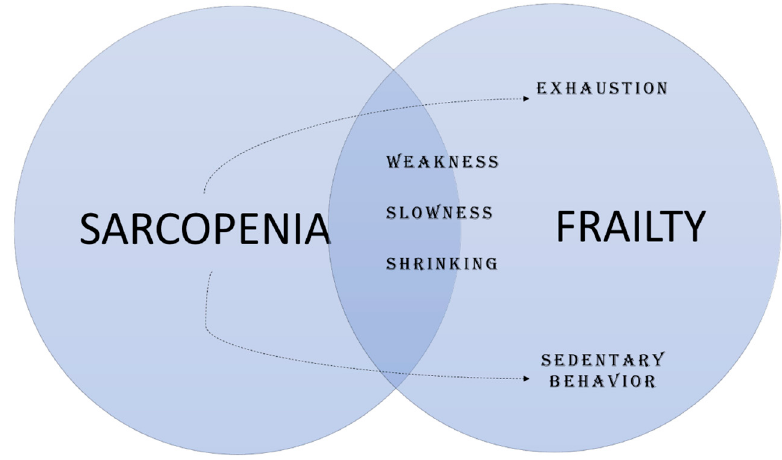
Figure 3. Sarcopenia and frailty.